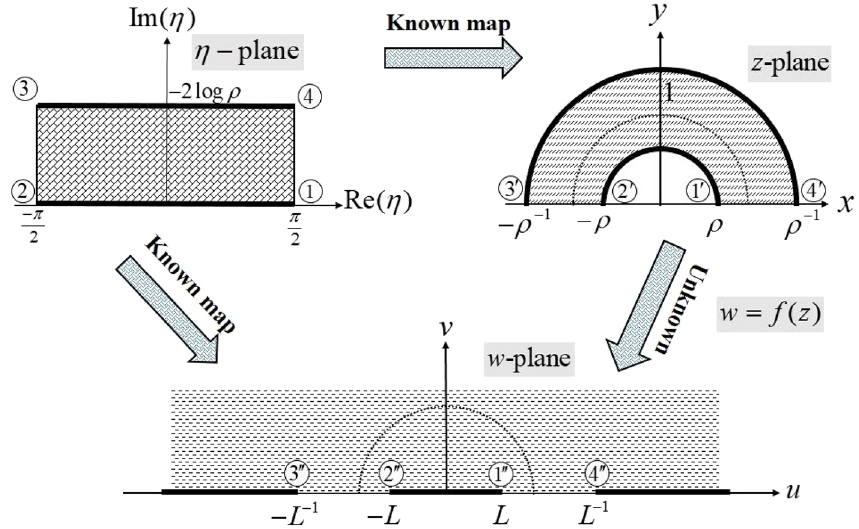
Figure 3. Schematic of the procedure for deriving the conformal map w = f ( z ) .